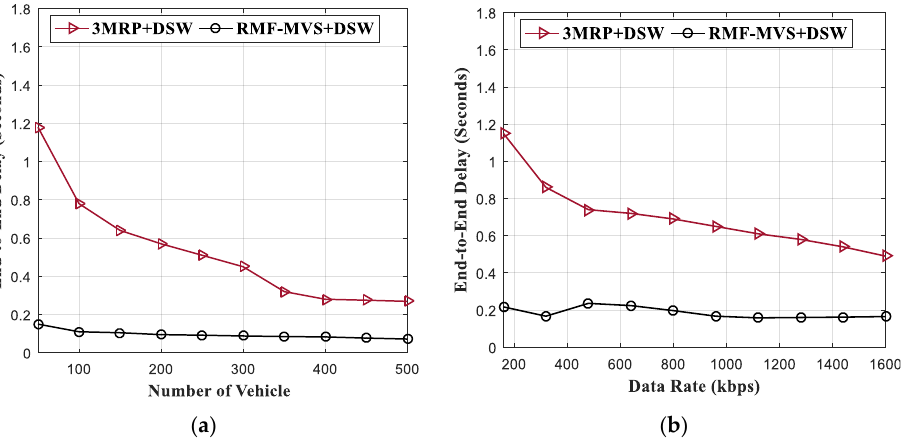
Figure 11. E2ED based on Varied Number of ( a ) Vehicles and ( b ) Data Rates Considering Dynamic Weighting Score.